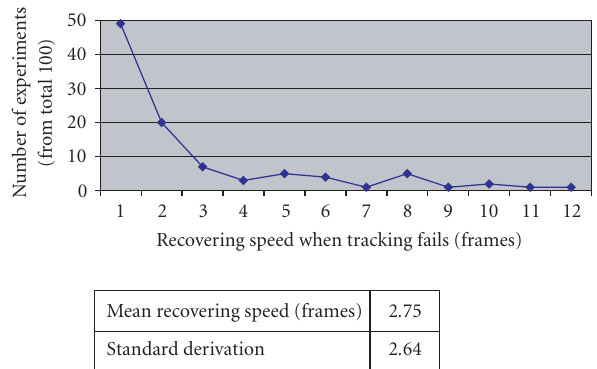
Figure 5: Speed used for recovering from tracking